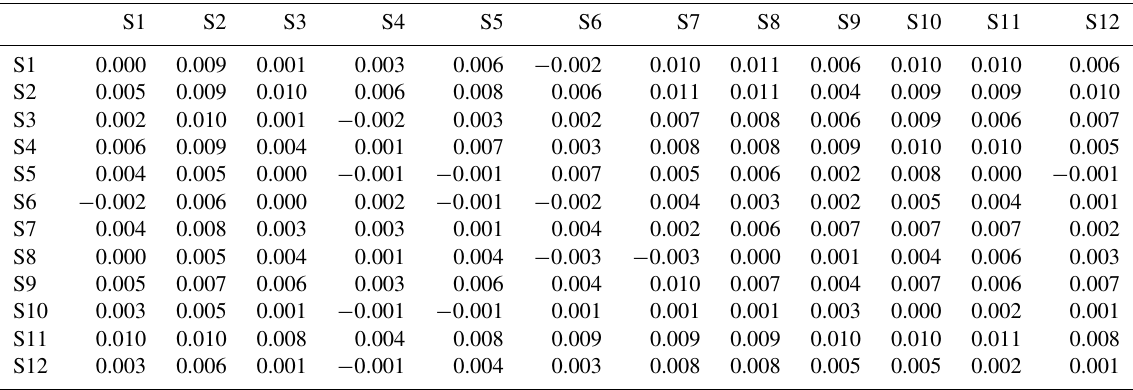
Table 9. Bias of lag-1 cross-correlation of the generated data from the DKNNR model. Note that a positive value indicates the overestimation of lag-1 cross-correlation, while a negative value shows underestimation. Note that bias = 1 /N of each term.